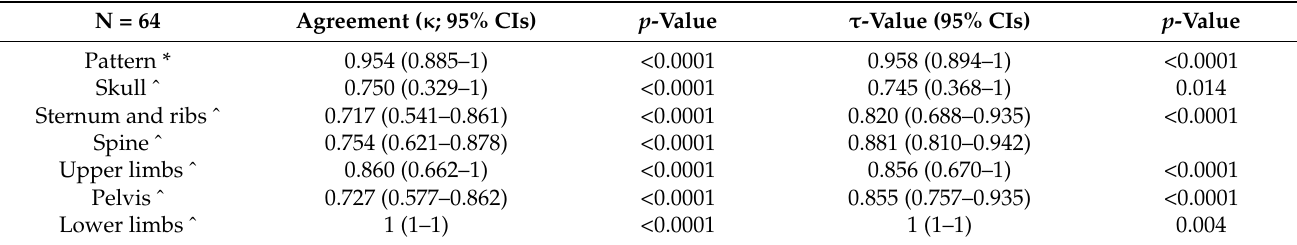
Table 2. Agreement between the two readers regarding MM pattern and lesions numbers according to anatomic districts (skull, sternum and ribs, spine, upper limbs, pelvis, and lower limbs). The 95% CIs were computed by bootstrap.